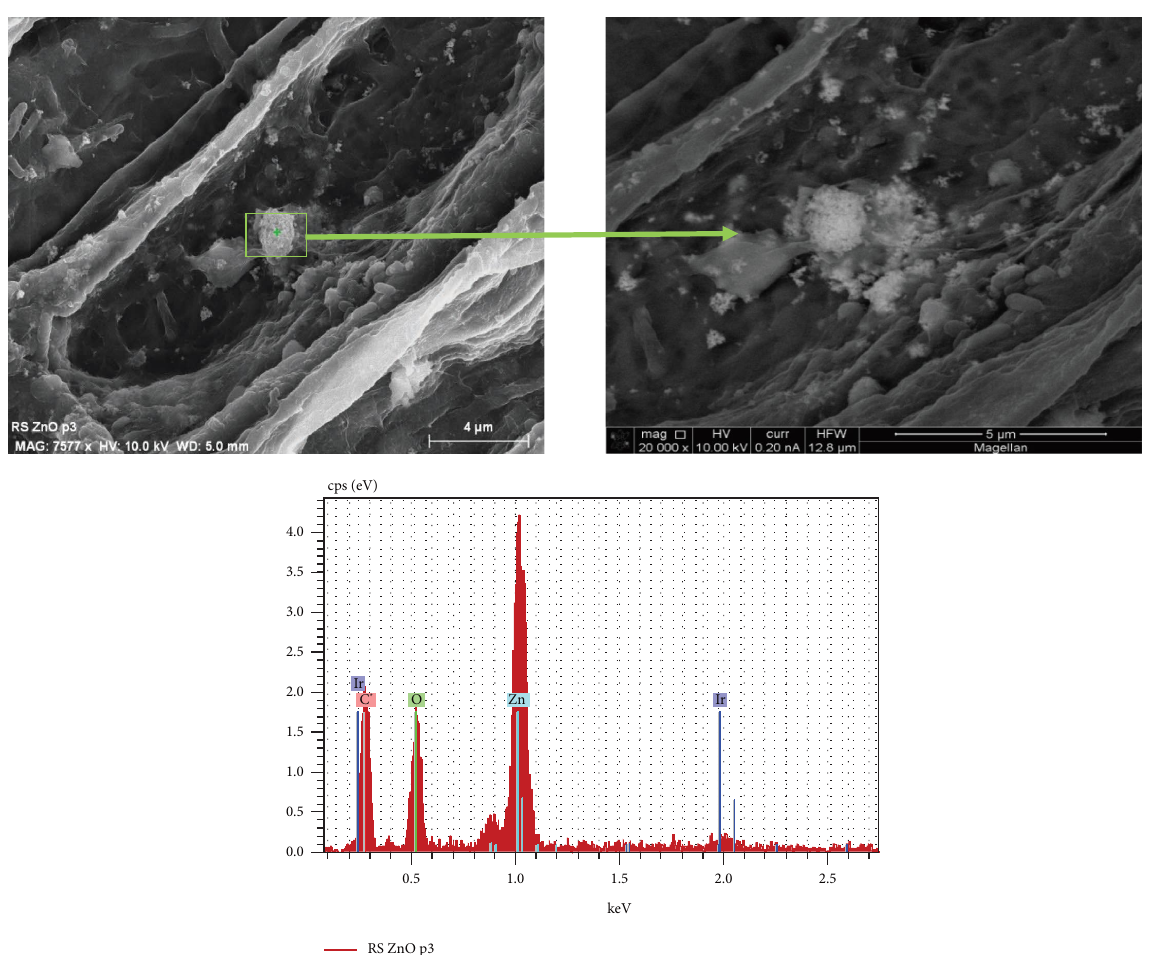
Figure 4: SEM/EDX image of cattail root showing the presence of ZnO